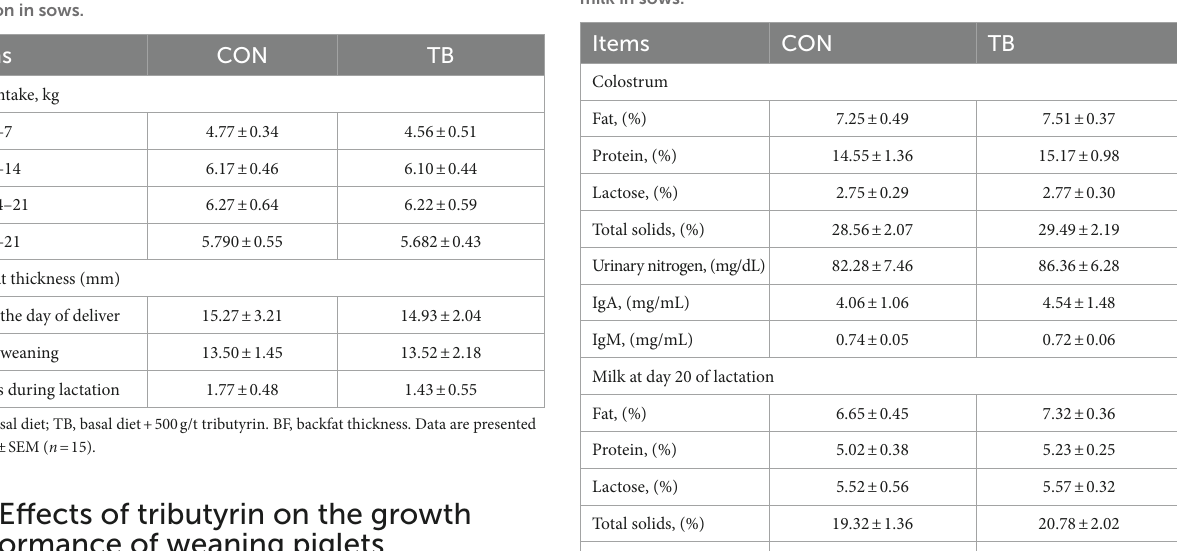
TABLE 4 Effects of tributyrin on composition of colostrum and regular milk in